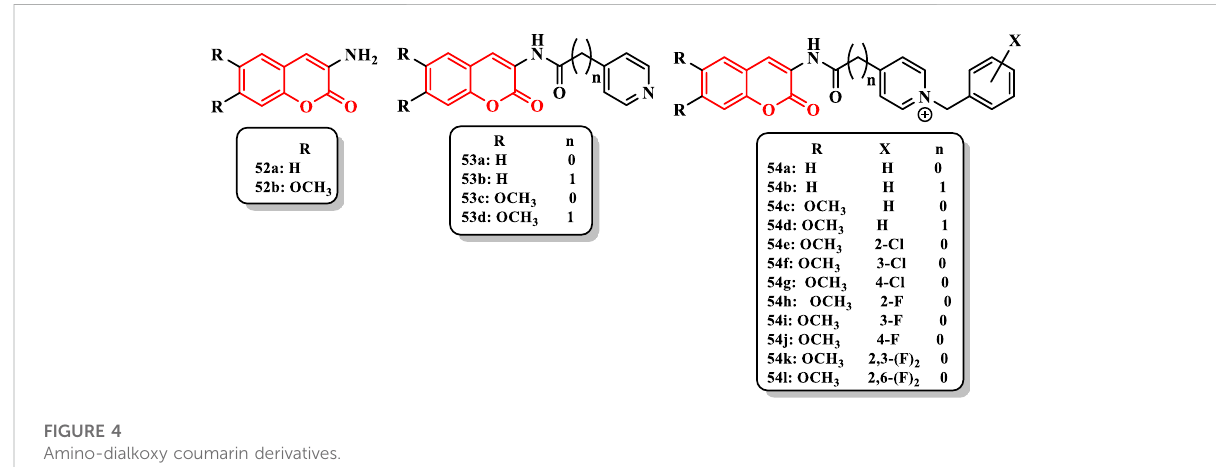
FIGURE 4 Amino-dialkoxy coumarin